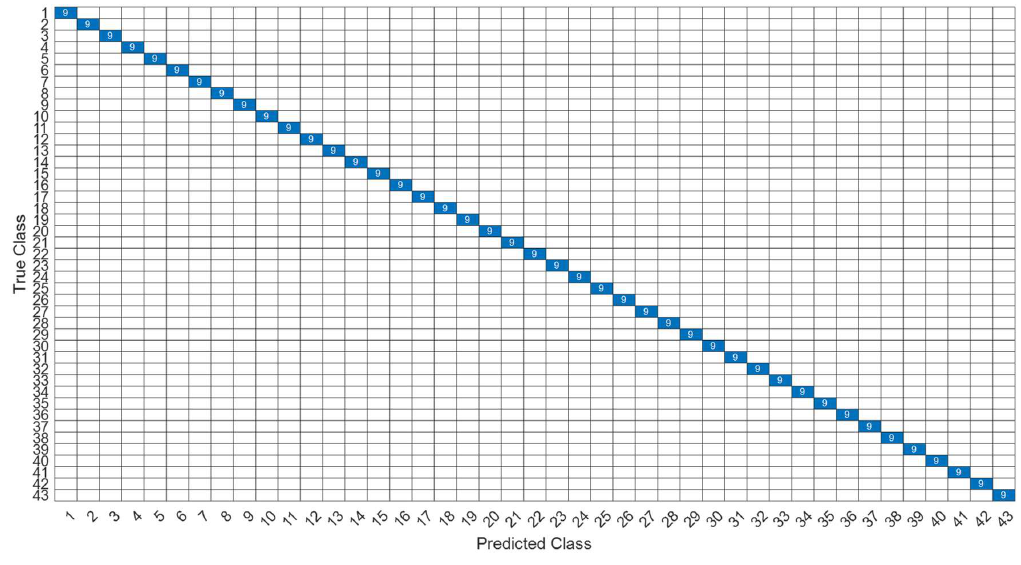
Figure 21. The confusion matrix of the CNN model with LPC 30-features dataset.